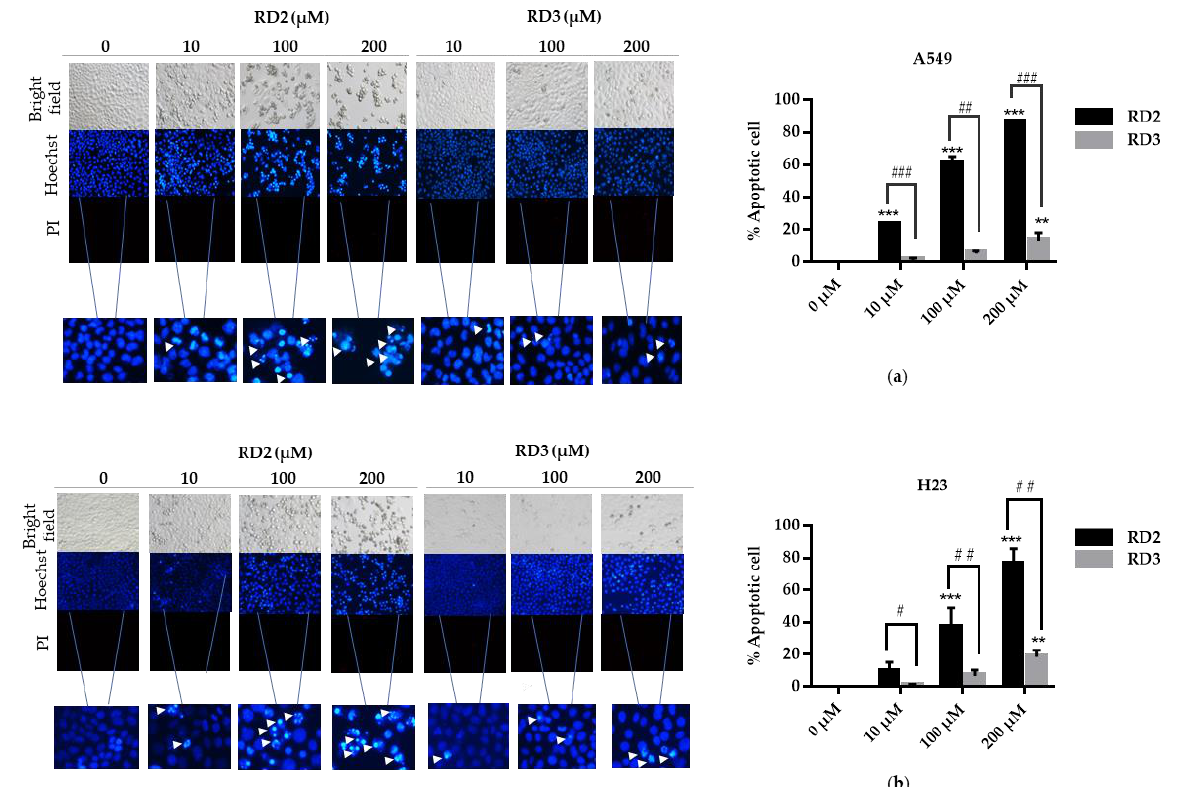
Figure 4. Resveratrol derivatives induces apoptosis in NSCLC. ( a , b ) Cells were treated with RD2 and RD3 (0–200 mM) for 24 h and then stained with Hoechst 33342 and PI. The images were visualized using an inverted fluorescence microscope. The condensed blue fluorescence of Hoechst 33342 represents the fragmented chromatin in apoptotic cells as a percentage compared with untreated control cells and another group. Data are represented as the mean ± SEM ( n = 3). * p < 0.05, ** p < 0.01, *** p < 0.001 when compared with the control group. # p < 0.05, ## p < 0.01, ### p < 0.001 when compared between RD2 and RD3.